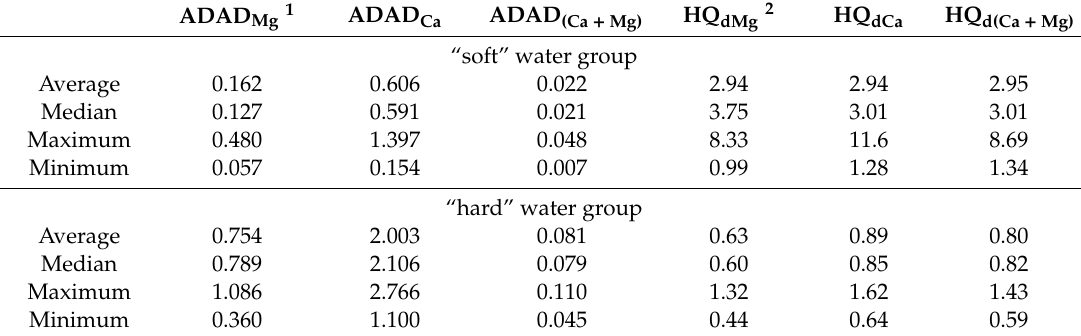
Table 6. Calculated HQ d values according to MRC derived from health